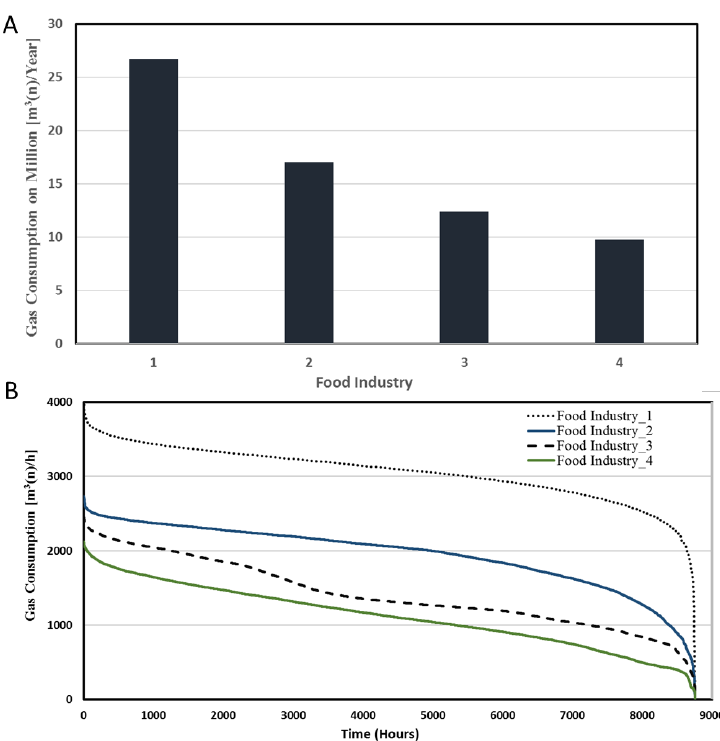
Figure 4. Gas consumption trend in different food processing industries. ( A ) Yearly consumption; ( B ) Consumption rate for one year when data are treated in descending order.